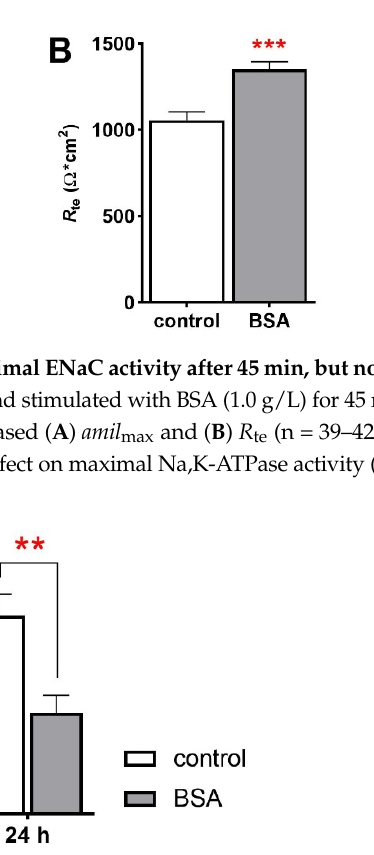
Figure 6. BSA decreases membrane permeability. FDLE cells were cultured in MEM and stimu- lated with BSA (1.0 g/L) for 45 min and 24 h. Data are displayed as mean + SEM normalized to control values. BSA significantly decreased membrane permeability (n = 11–12; ** p < 0.01 by t -test).